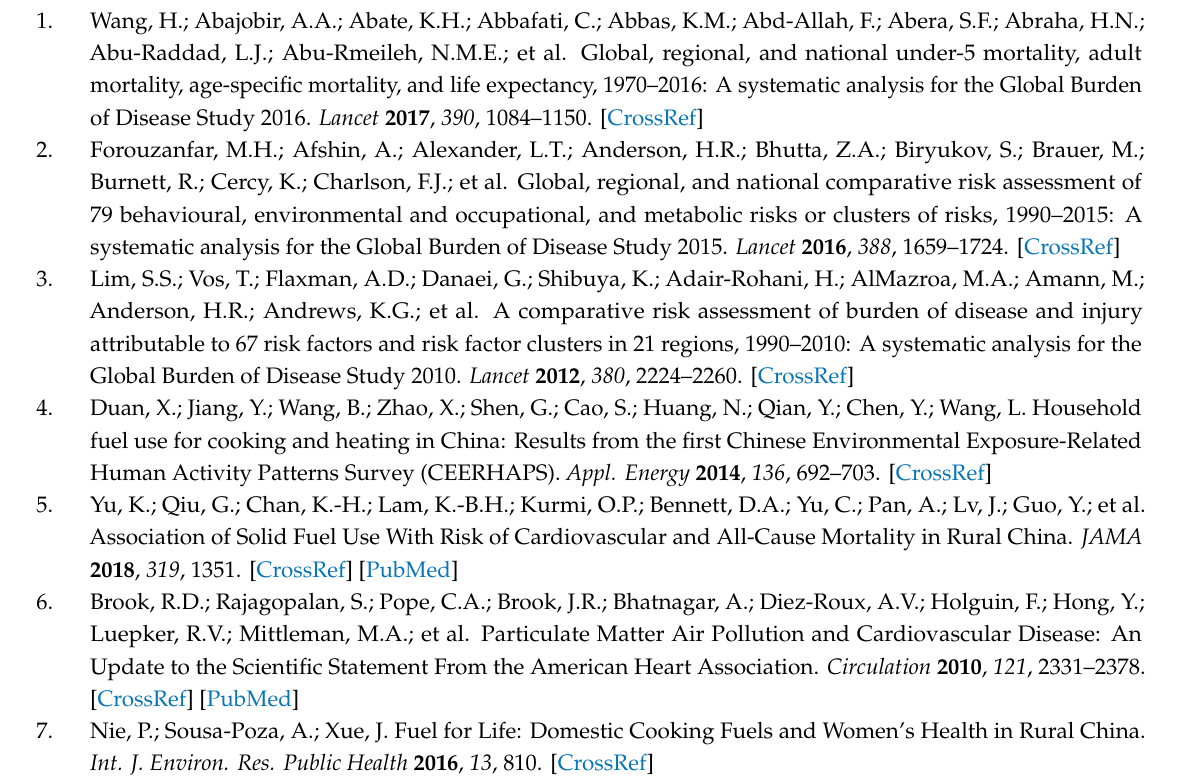
Figure S1: Summary of participant